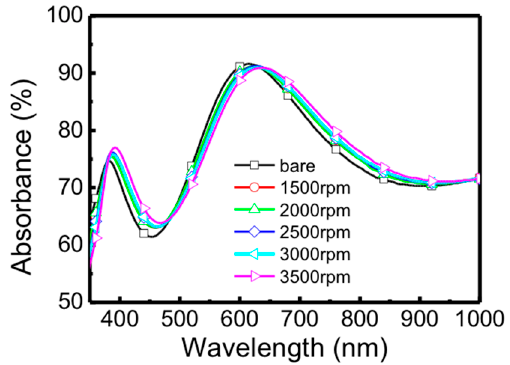
Figure 5. Absorbance spectra of rGO with a spin rate of 3000 rpm and 60–80 nm Ag nanoparticle-rGO with spin rates of 1500 nm, 2000 nm, 2500 nm, 3000 nm and 3500 nm, respectively.